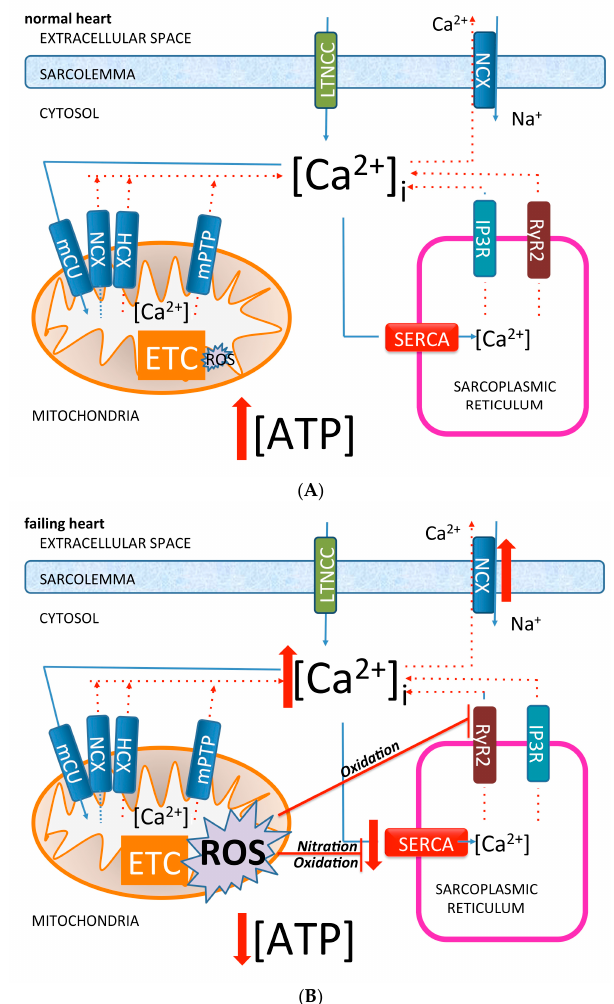
Figure 1. Diagram of subcellular interaction between subcellular calcium compartmentation and reactive oxygen species (ROS) in normal ( A ) and failing ( B ) cardiomyocytes. LTCC: L-Type Calcium Channel; NCX: Sodium-Calcium Exchanger; HCX: Hydrogen-Calcium Exchanger; mCU: Mitochondria Calcium Uniporter; mPTP: Mitochondrial Permeability Transition Pore; SERCA: Sarco/Endoplasmic Reticulum Ca 2+ -ATPase; IP3R: Inositol Trisphosphate Receptors; RyR: Ryanodine Receptors; ROS: Reactive Oxygen Species; ETC: Electron Transport Chain. Dotted lines indicate Ca 2+ efflux; full line indicate Ca 2+ influx.